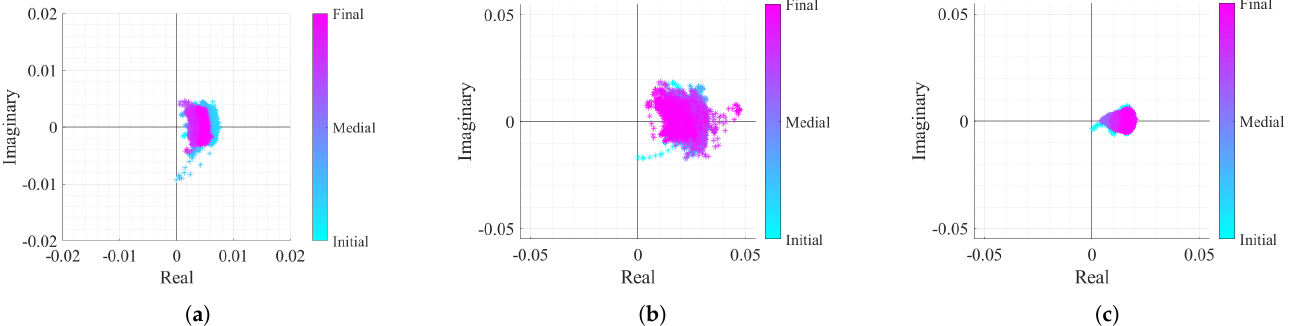
Figure 17. Real/Imaginary plots of the considered case study signals after the DSP algorithm implementation: ( a ) Case 1, ( b ) Case 2, ( c ) Case